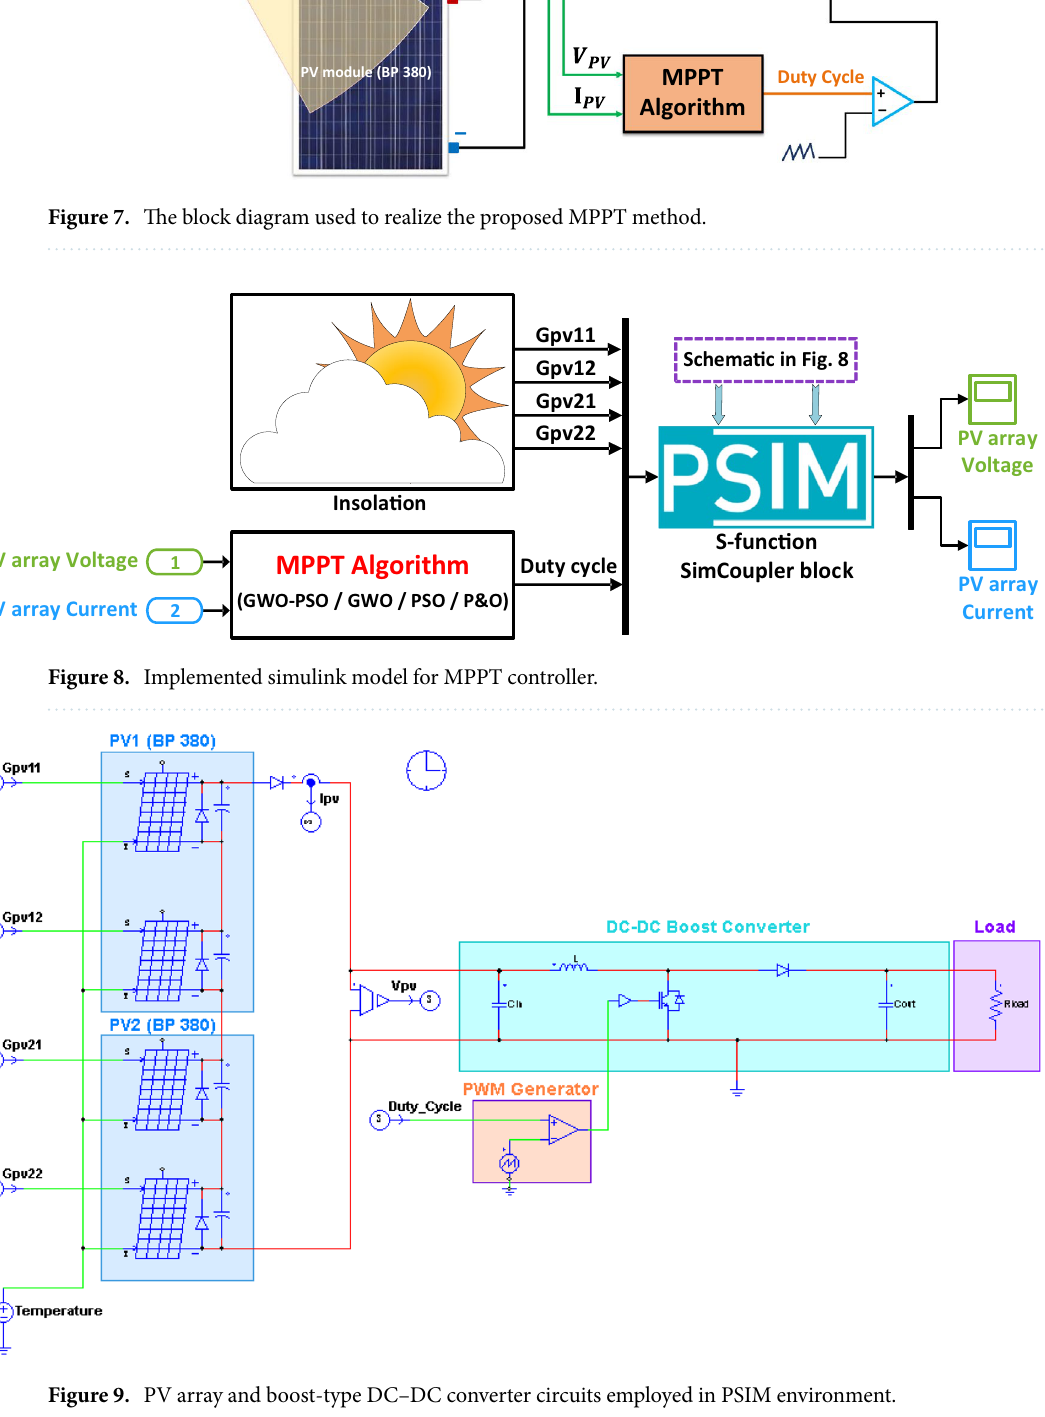
Figure 9. PV array and boost-type DC–DC converter circuits employed in PSIM